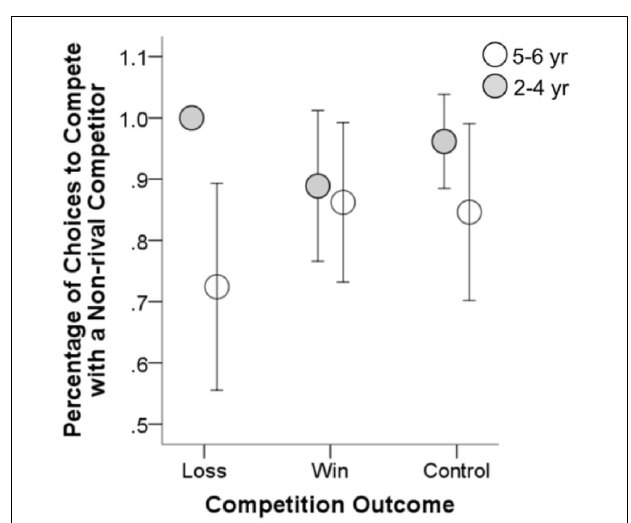
FIGURE 2 | Mean percentage of choices to compete with a non-rival competitor as a function of age and competition outcome. Error bars represent 95% confidence